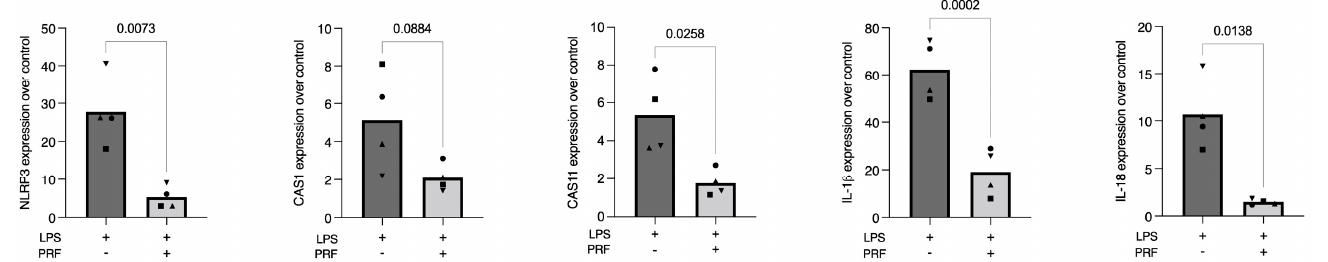
Figure 2. PRF reduces the expression of pyroptosis-related genes in LPS-induced primary macrophages. A significant reduction in NLRP3, CAS11, IL-1 β , and IL-18 in LPS-challenged primary macrophages was reported. Gene expression is compared to the untreated control, and each data point represents an independent experiment. n = 4. To compare groups, paired t -test was